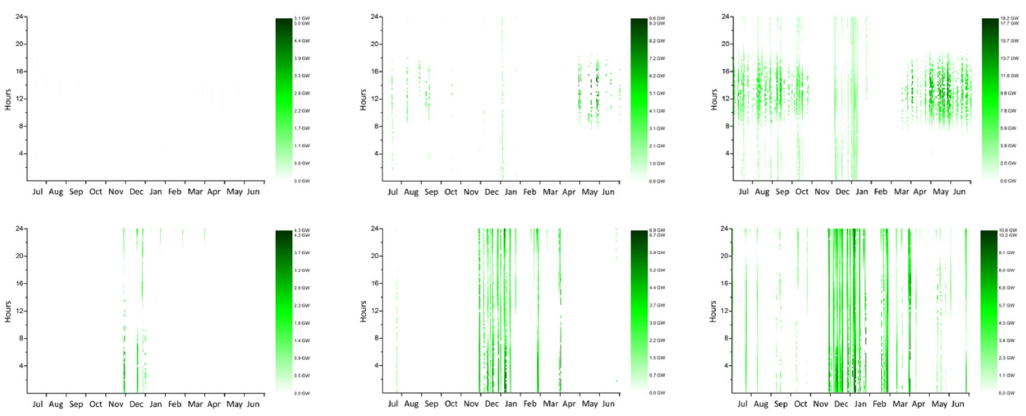
Figure 4. Remaining excess power in each 15 ‐ minute time step in the different scenarios (above = solar PV ‐ dominated region, below = wind power ‐ dominated region, left = 50% RES, middle = 65% RES, right = 80%